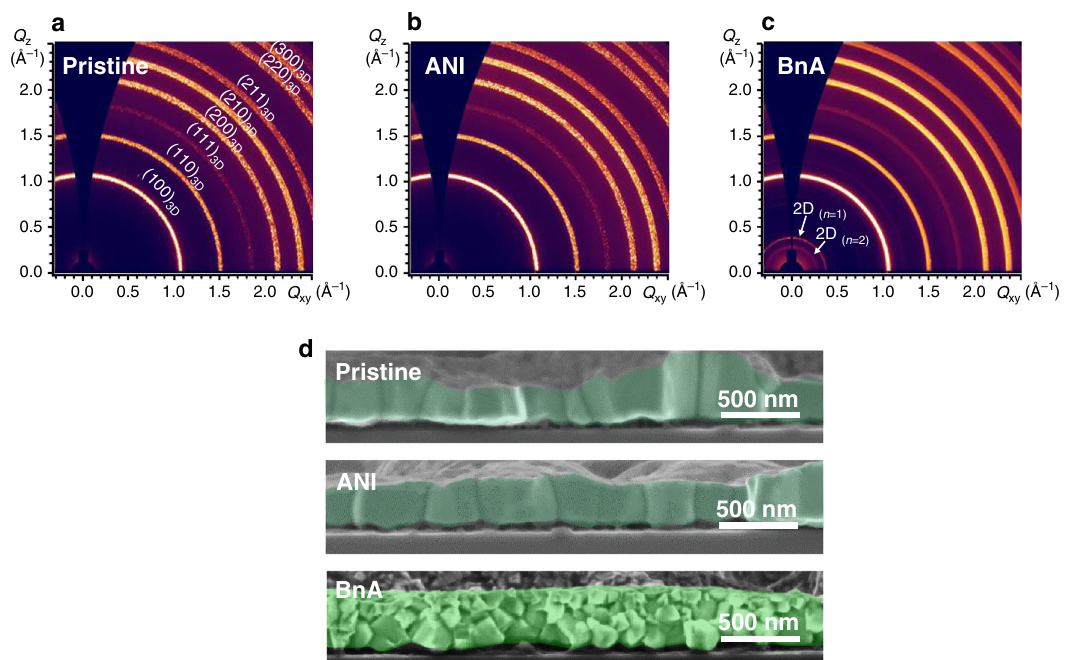
Fig. 3 Crystal structure and morphology of MAPbBr 3 according to the addition of ANI or BnA. a – c 2D GIXD patterns of pristine MAPbBr 3 , MAPbBr 3 with 2.4 mol% ANI, and 2.4 mol% BnA. d Cross-sectional SEM images of pristine MAPbBr 3 (top), MAPbBr 3 with 2.4 mol% ANI (middle), and 2.4 mol% BnA